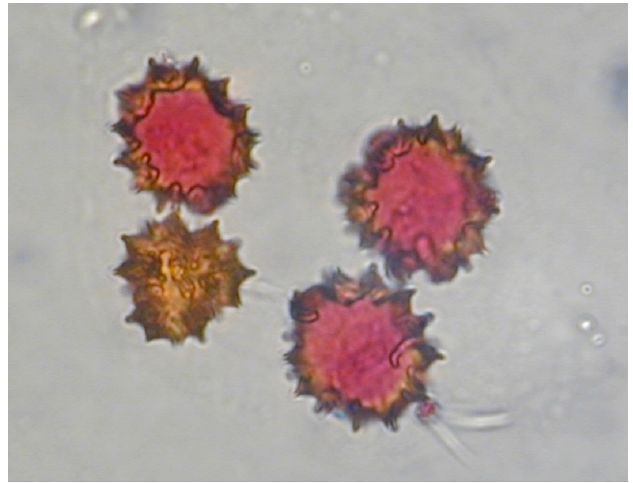
Fig. 5: Infertile pollen (yellow, in the lower left corner) vs. fertile pollen (red, the other three) in the F1-generation